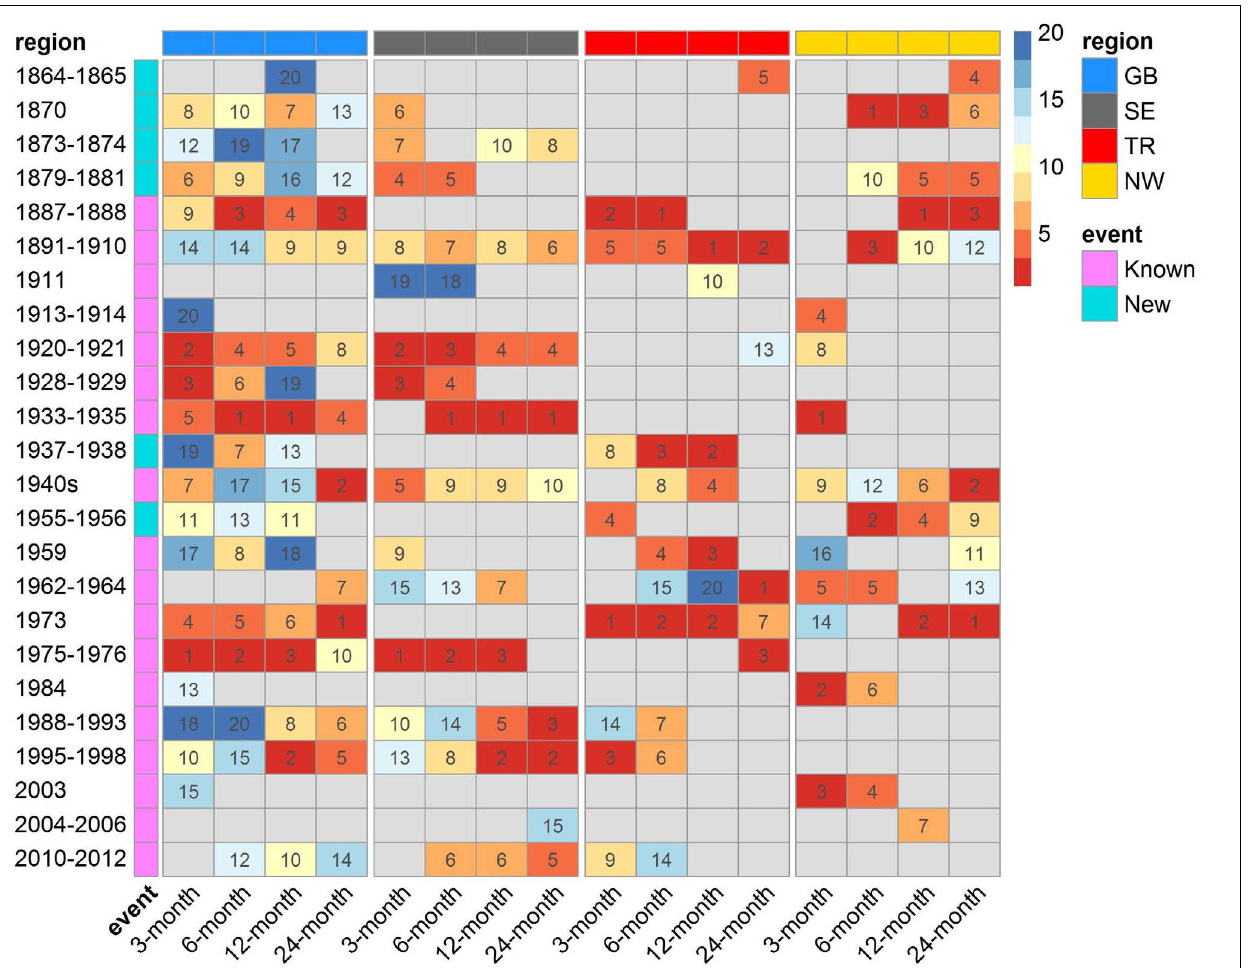
FIGURE 11 | List of major droughts identified in this study. Each line in the plot corresponds to a major drought event identified in this study. The drought events marked in pink (on the left hand side of the plot) are major droughts previously reported in the literature, the ones marked in blue are new ones identified in this study. The plot is organised in four vertical blocks corresponding to Great Britain and the three regions (i.e., SE, Transition region, and NW). Each of these four blocks are in turn divided into four columns corresponding to the accumulation periods considered in this study (i.e., 3, 6, 12, and 24 months). The colour (and number) in each cell shows the ranking of the drought based on severity. For cells that are greyed out, the rank of the drought is greater than 20.